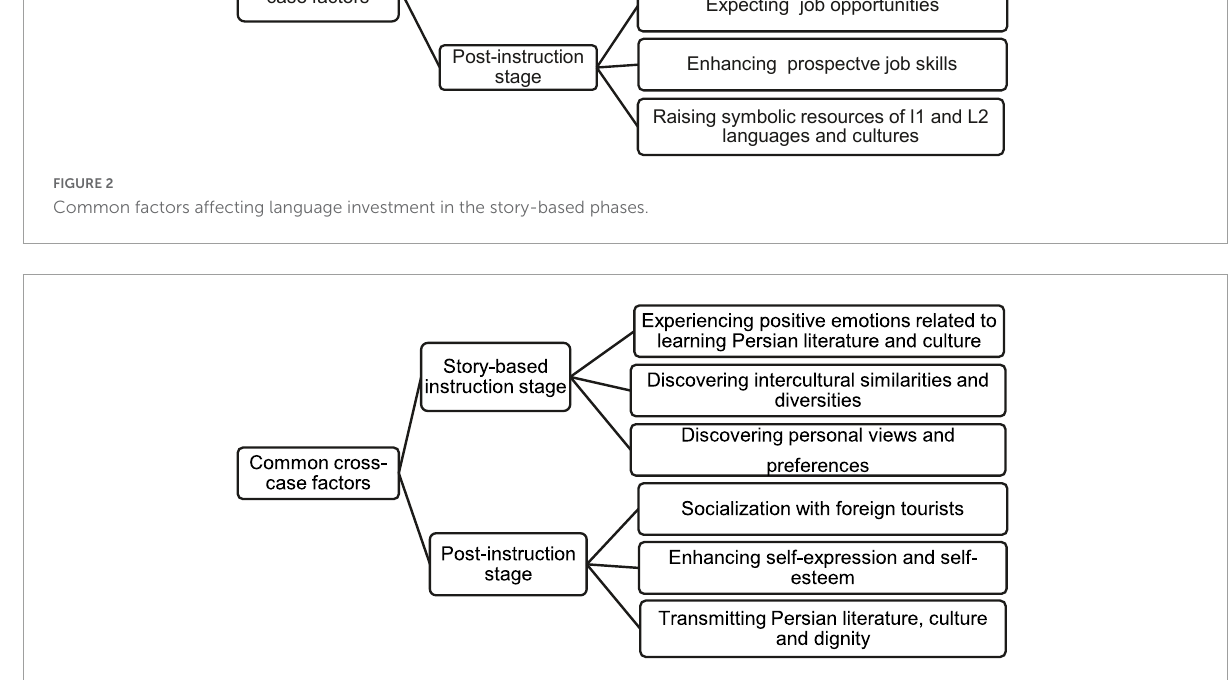
FIGURE3 Common factors affecting language consumption in the story-based